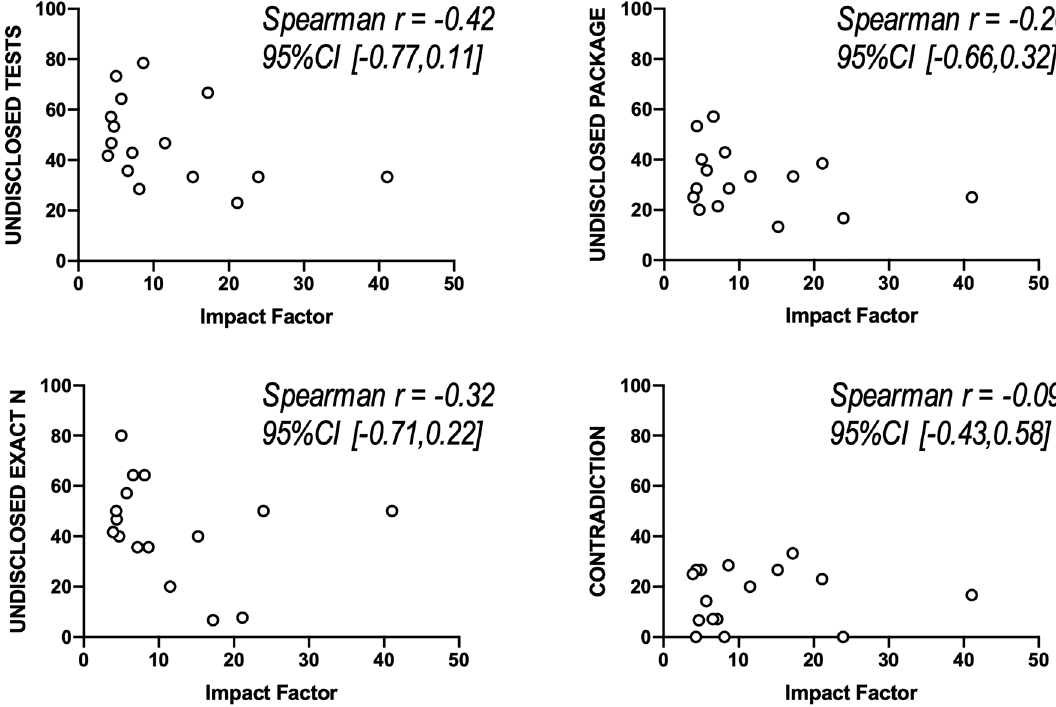
Figure 2. Scatter plots showing the correlation study between percentage of incomplete reporting and journal impact factor (2018). 95% confidence interval of Spearman correlation coefficient are given between brackets. Each dot represents one journal (k =